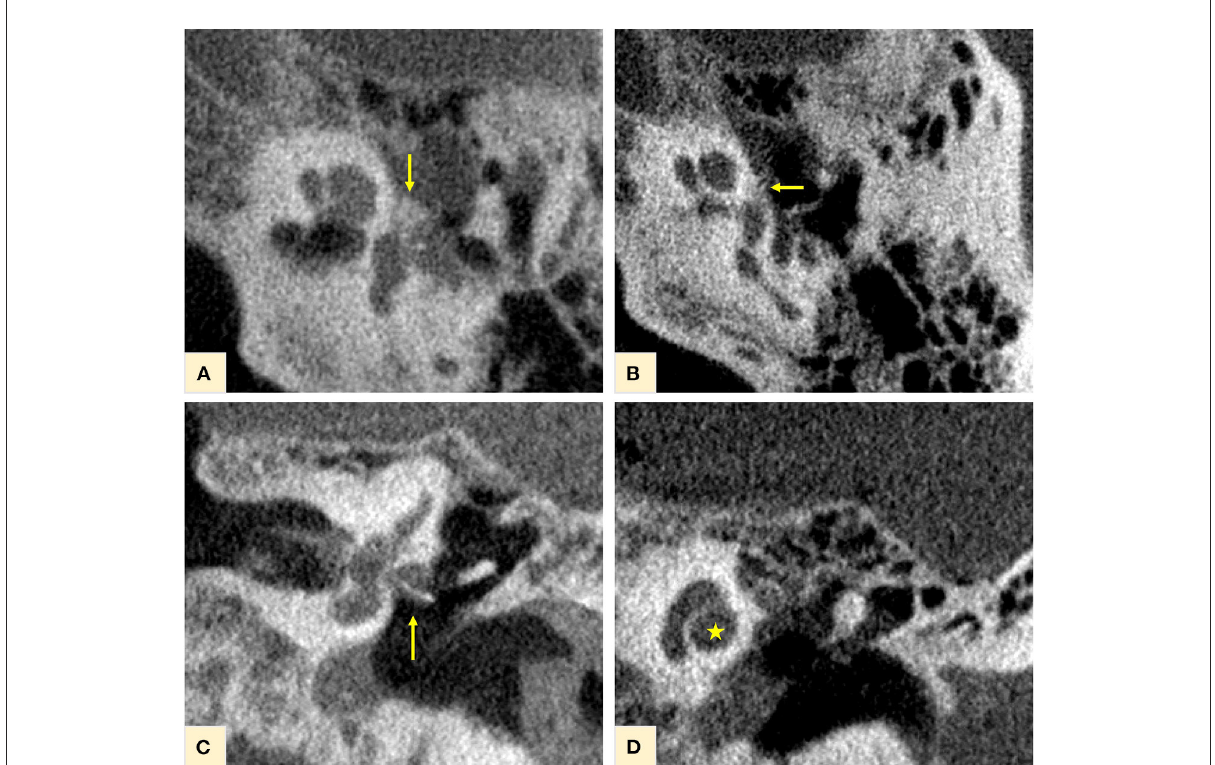
FIGURE2 CBCT of the temporal bone. Otospongiotic plaques in loco typico confirming the disease diagnosis, were clearly recognizable at the fissula ante fenestrum, with involvement of the oval window and the “otosclerotic angle” [yellow arrows in (A,B) ]. The titanium stapes prosthesis in situ for disease treatment is shown on (C) (yellow arrow). At this initial stage of the disease, no other otospongiotic foci were seen and the cochlea appeared with a normal contour on (D) (yellow